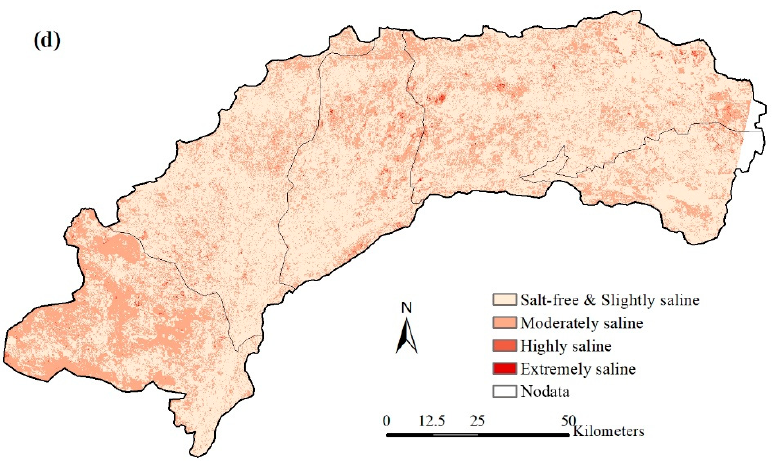
Figure 11. The spatial distribution of saline classes in Hetao: ( a ) 1989, ( b ) 1999, ( c ) 2010, and ( d ) 2019.